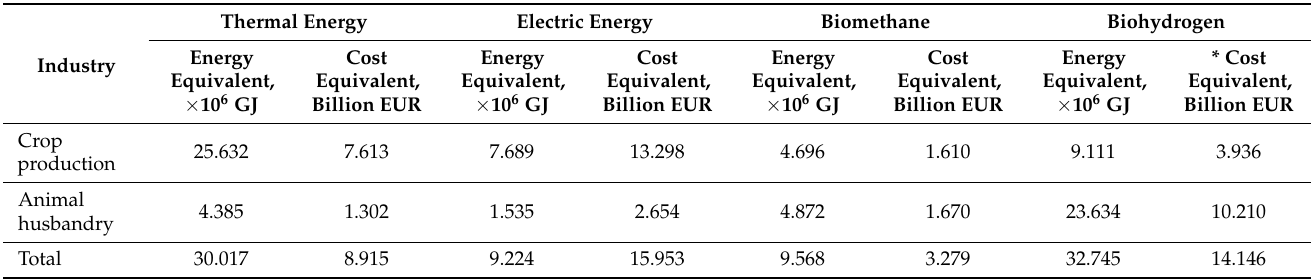
Table 1. Energy and cost equivalents of the biomass potential of agricultural